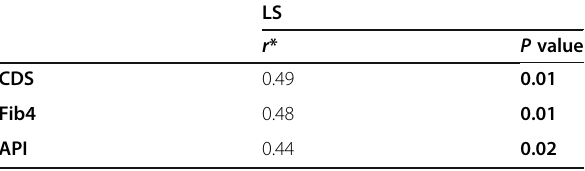
Table 6 Correlation between noninvasive liver fibrosis